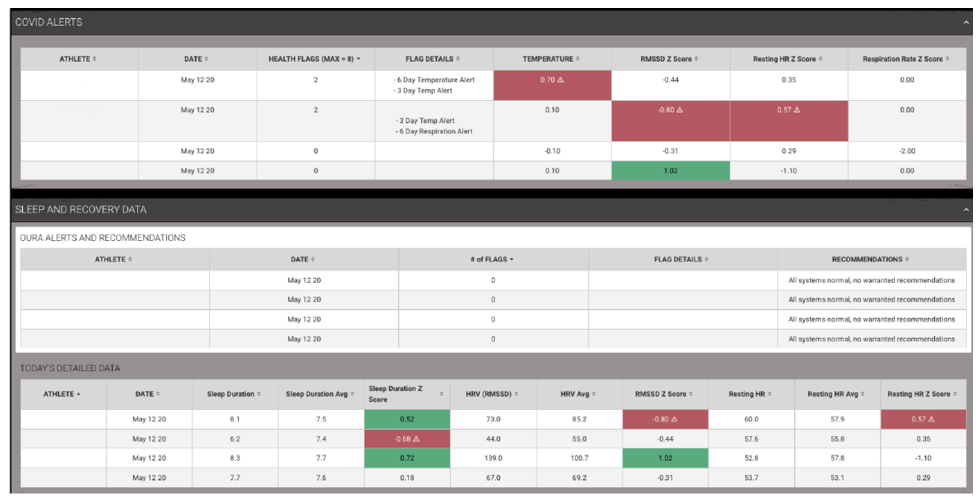
Figure 6. Sleep Physiology COVID-19 Example Alert Dashboard.